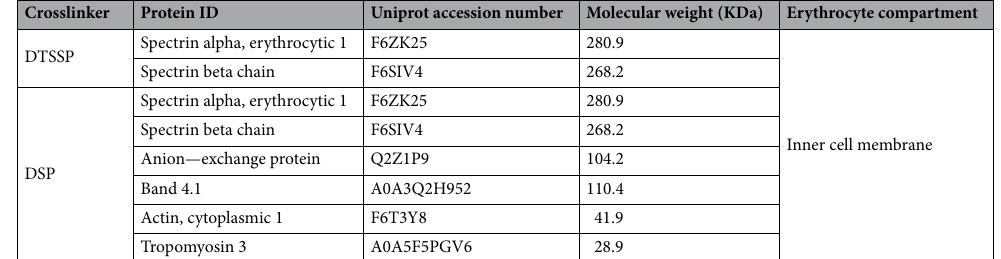
Table 1. CLAMP interacts with components of the erythrocyte membrane skeleton in the inner cell membrane of equine erythrocytes.